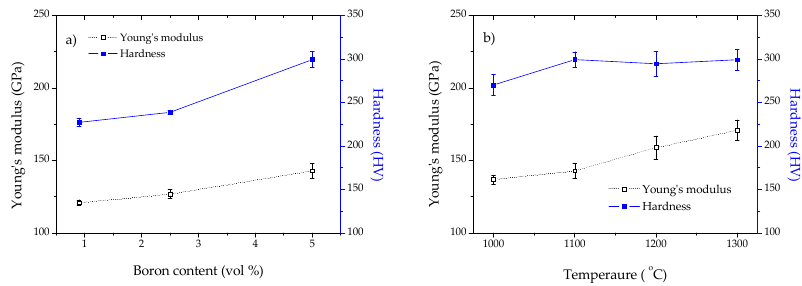
Figure 9. ( a ) Hardness and Young’s Modulus vs. volume percentage of Boron (vol %), ( b ) Hardness and Young’s Modulus vs. operational temperatures.